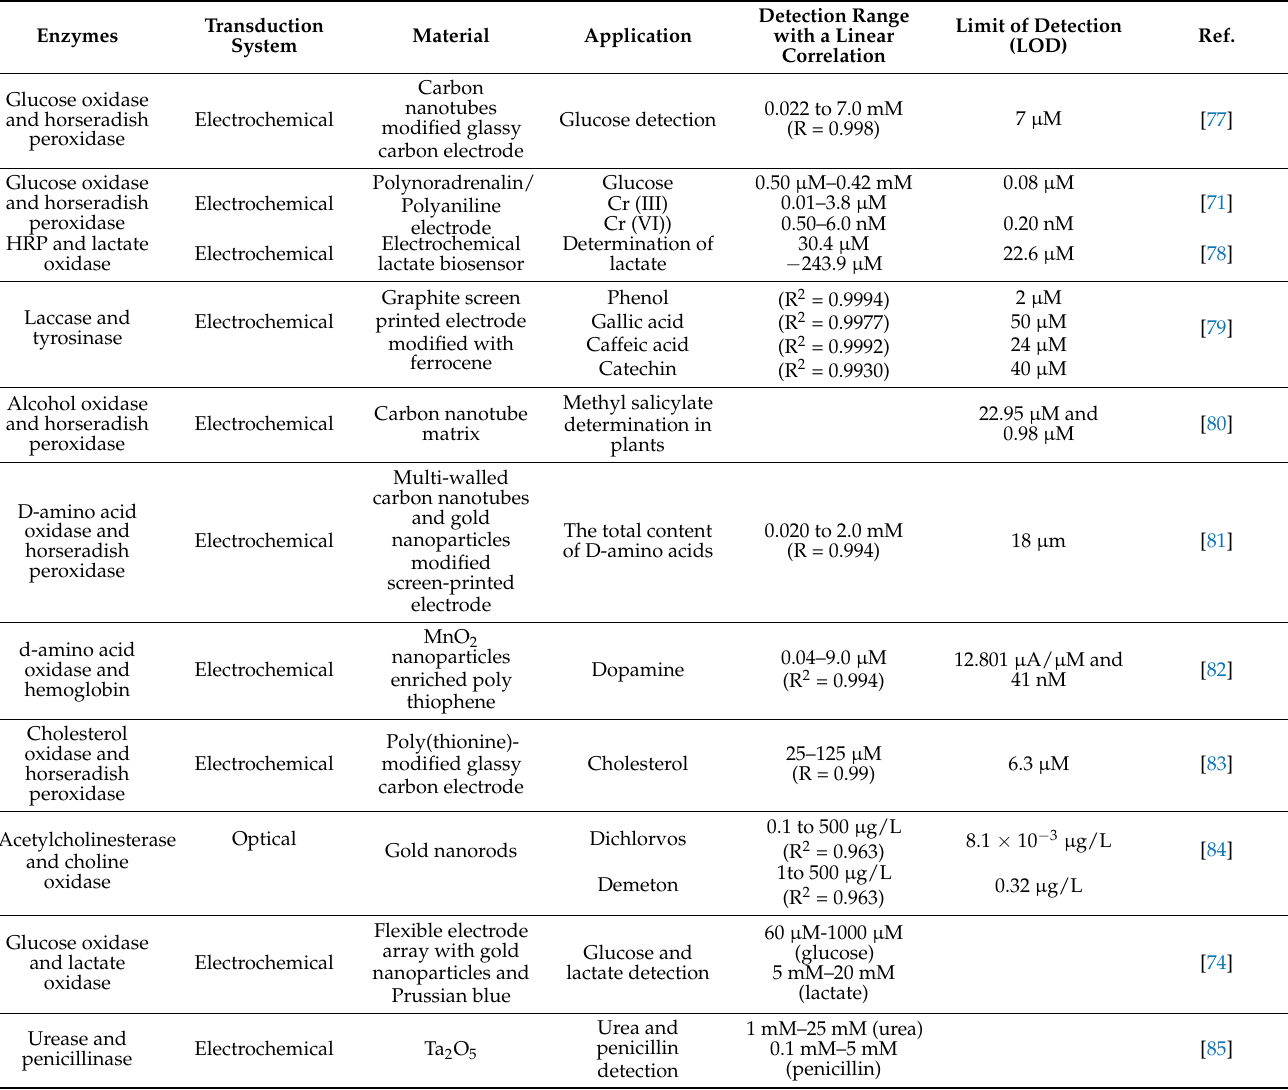
Table 5. Bi-enzyme systems for biosensors, specifications, and